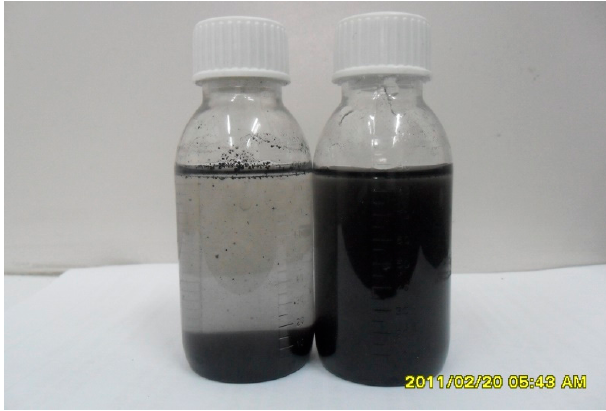
Figure 11. Comparison of graphene suspension before and after adding SDBS for 60 days.